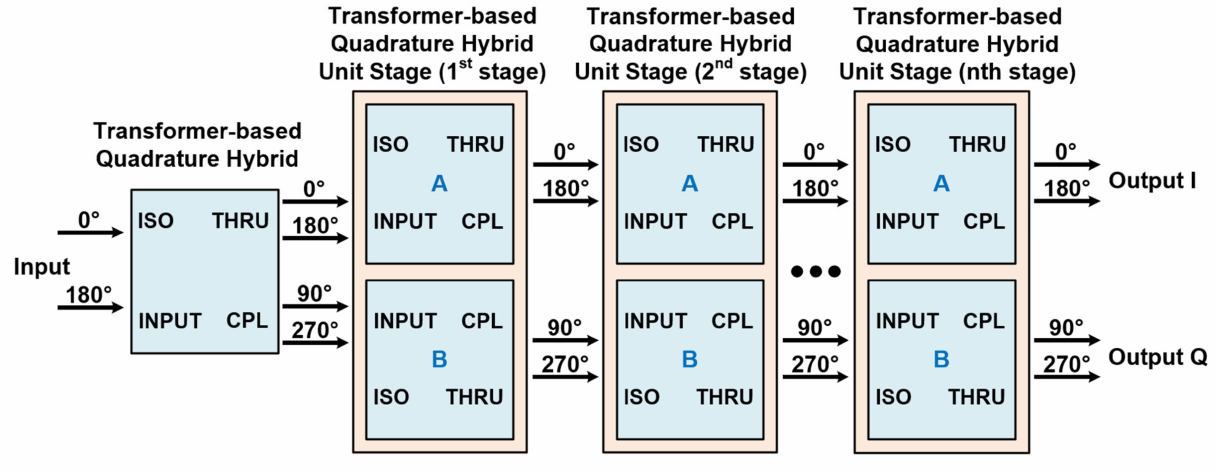
Figure 7. Block diagram of cascaded transformer-based quadrature